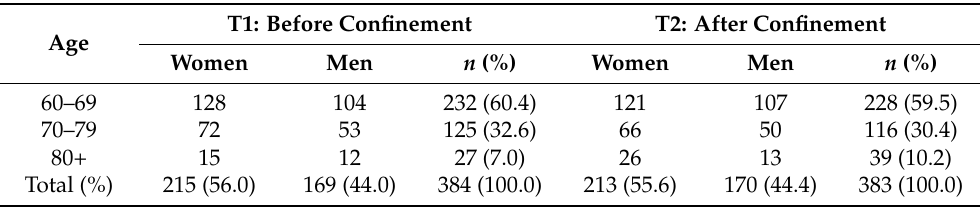
Table 1. Summary of age and sex distribution of the sample of participants, before and after confine- ment in elderly adults from